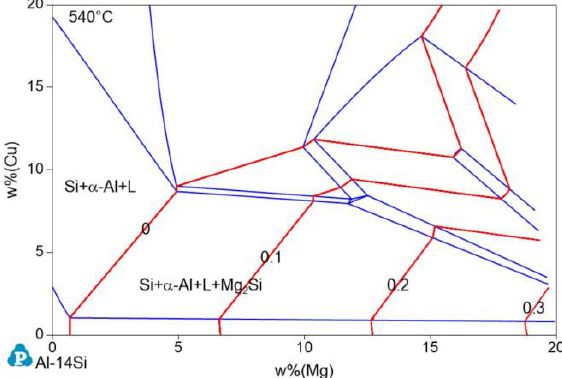
Figure 2. Phase diagram of the isothermal cross section of the Al − 17Si − Cu − Mg alloy system at 540